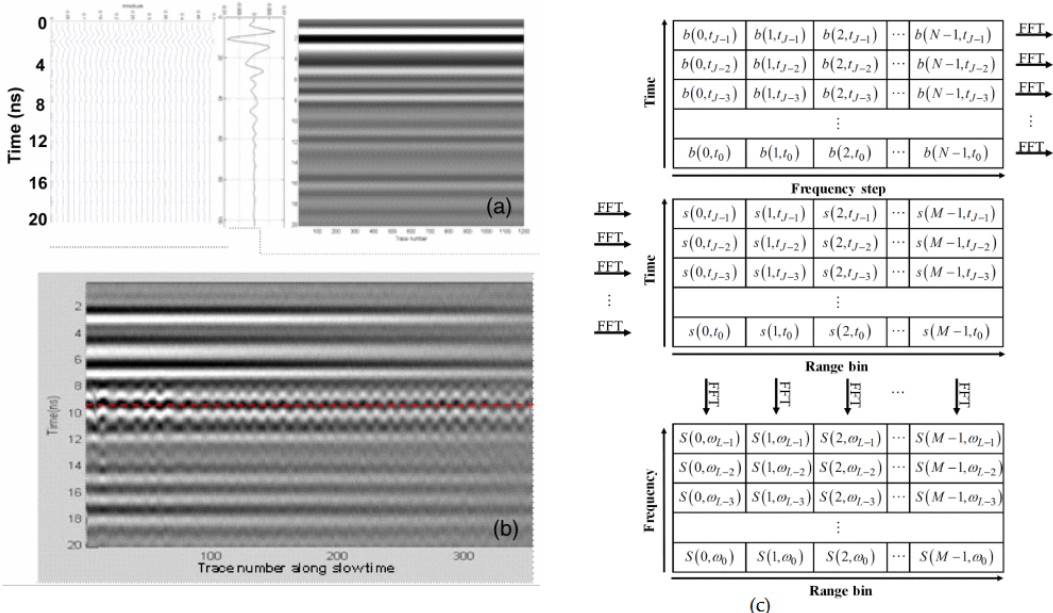
Figure 15. ( a ) Time-domain SFCW radar data with presence of human subject after applying inverse fast Fourier transform (IFFT); ( b ) vital signs after cancelling the clutter effect [146]; ( c ) algorithm used to obtain the range-Doppler profile